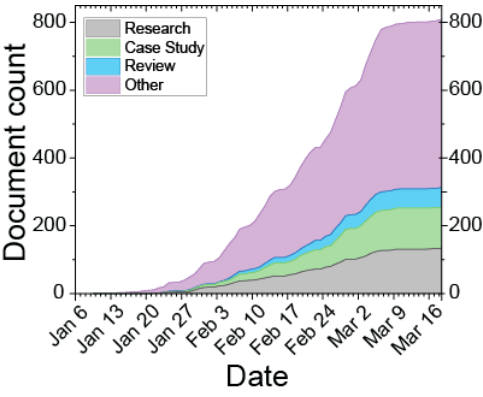
Figure 1. Cumulative number of documents by date on COVID-19 in the study period. The different document types are color coded and their count stacked on each other.